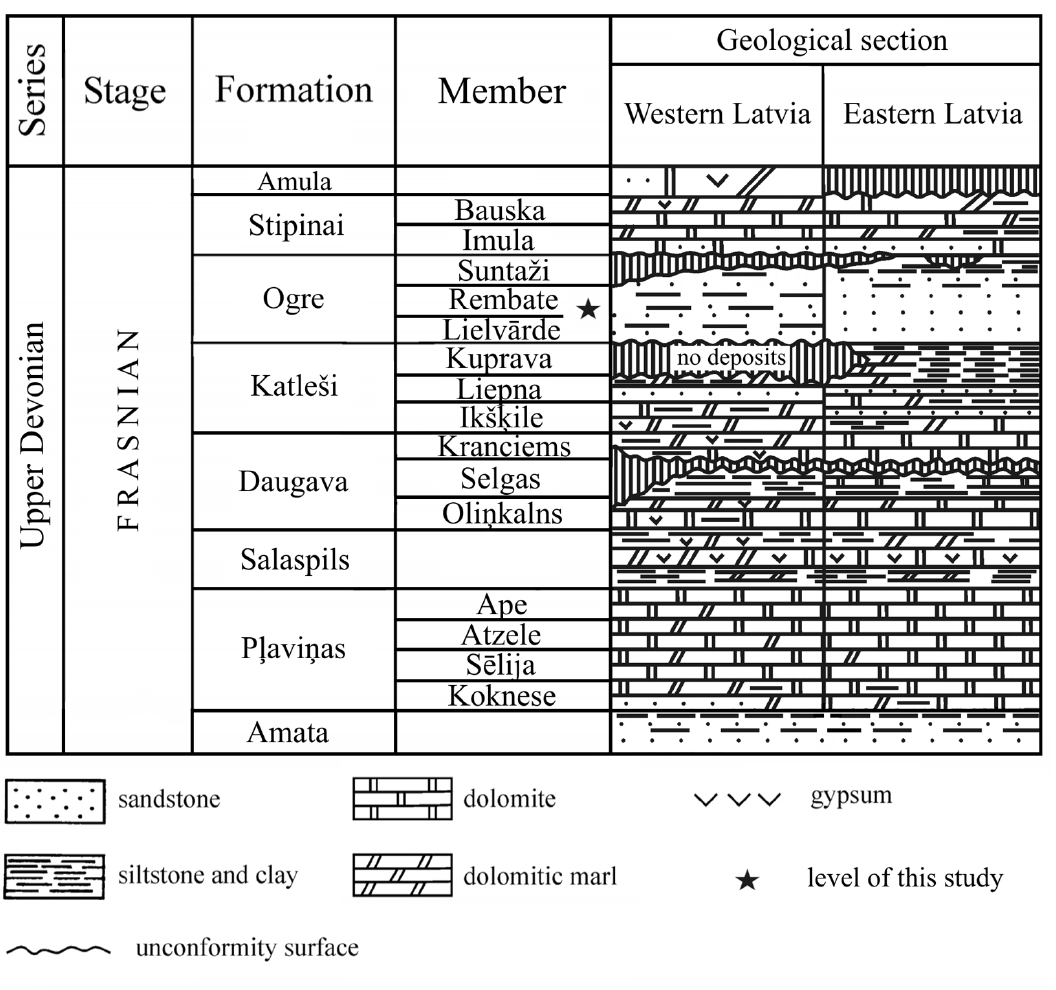
Fig. 1. Stratigraphy and schematic geological section of the Frasnian deposits in Latvia (modified from Lukševičs et al.